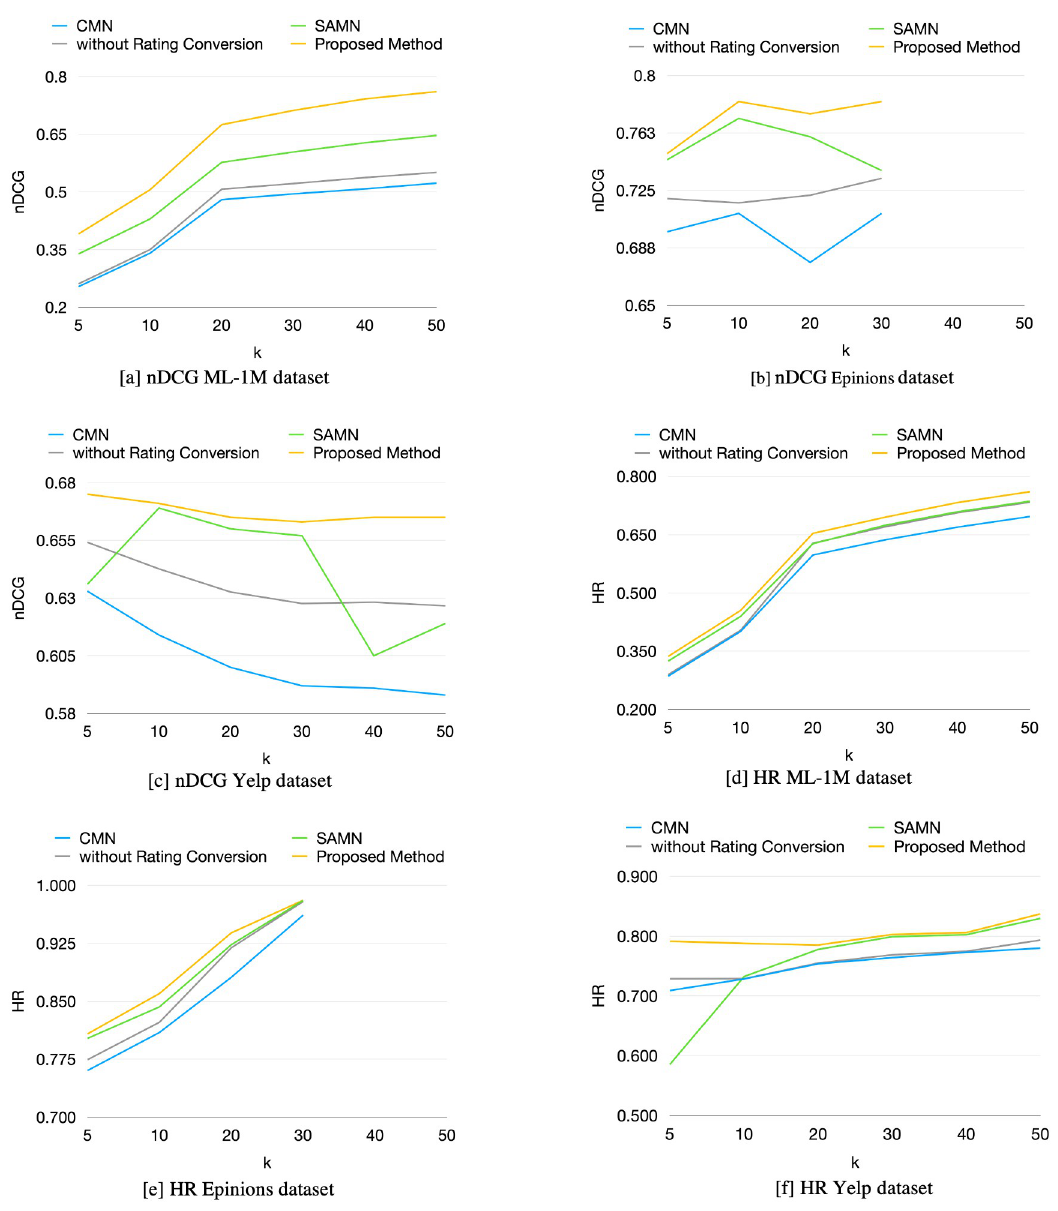
Fig 7. Experimental results graph comparison on the ML-1M, Epinions, and Yelp datasets using the nDCG and HR. [a] nDCG ML-1M dataset. [b] nDCG Epinions dataset. [c] nDCG Yelp dataset. [d] HR ML-1M dataset. [e] HR Epinions dataset. [f] HR Yelp